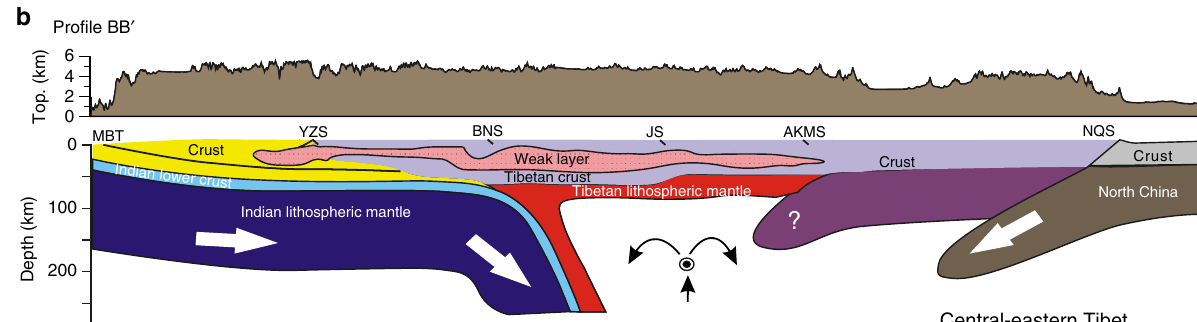
Fig. 6 Cross-section showing lithospheric structures of the Tibetan plateau. a The integrated schematic cross-section in western Tibet. The lithospheric structure is derived from the seismic data 5,6 ; the crustal tectonic structure is from Searle et al. 67 and Yin and Harrison 3 . b The integrated schematic cross- section in central – eastern Tibet, which is modi fi ed after Owens and Zandt 13 and Ye et al. 40 . The weak layer in the middle crust is after Wang et al. 68 . The mantle fl ow underneath central and northern Tibet is supposed to be eastward 69 . The locations of both pro fi les are marked in Fig.